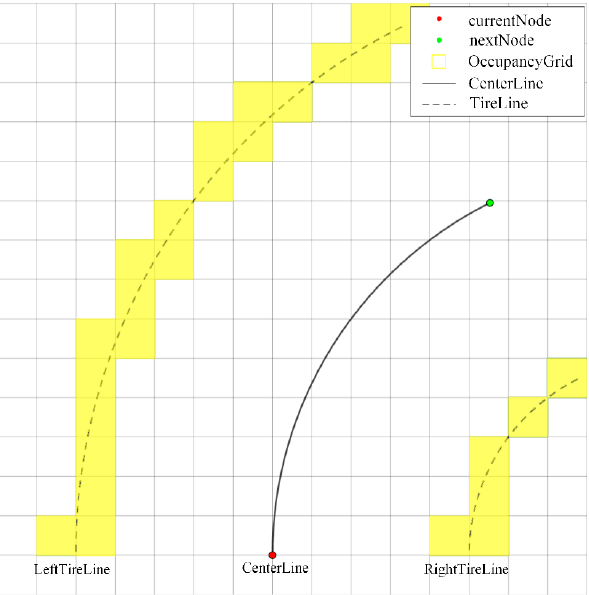
Figure 10. Schematic diagram of the tire-contact cost estimation. The black solid line is the extension line from the current node to the next node. The dashed is the tire path calculated from vehicle properties. The yellow area is the occupied grid of the tire path.